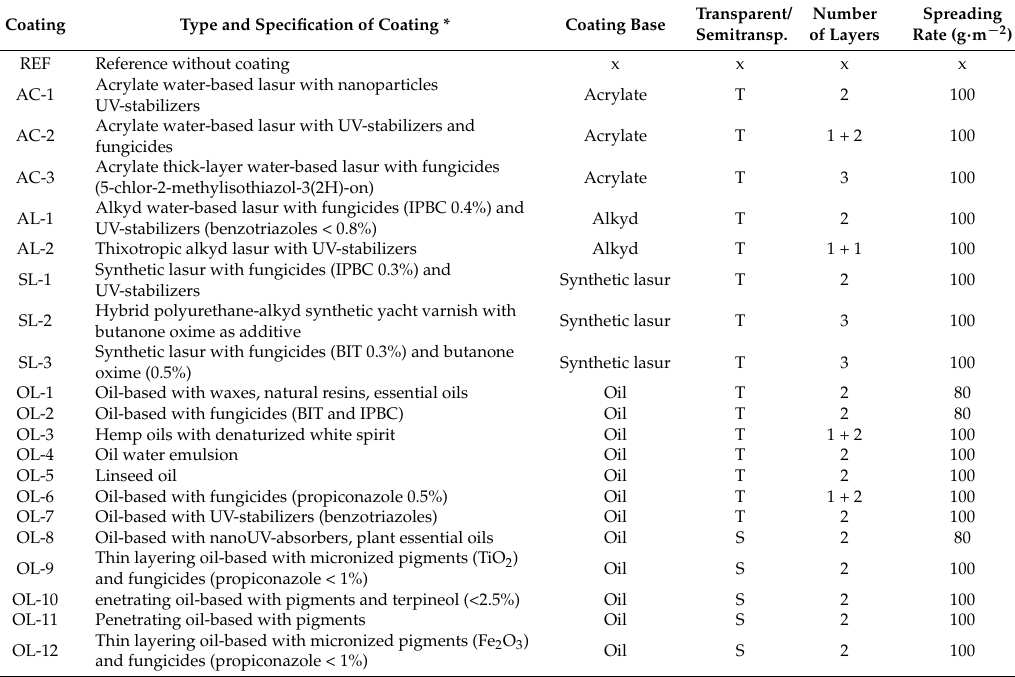
Table 1. Specification of tested coating